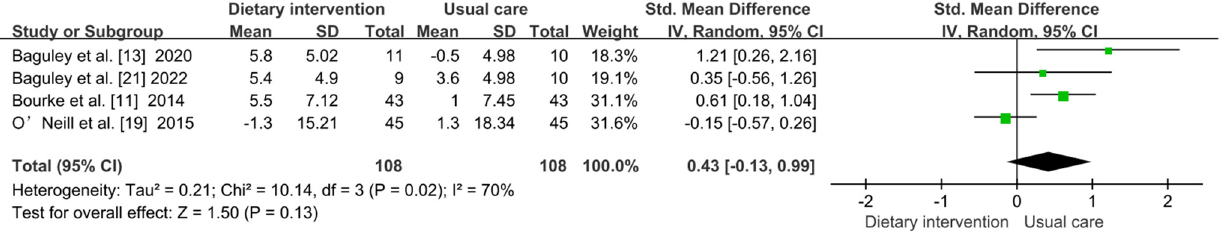
Figure 6. Fatigue: f orest plot of effect of healthy DP on fatigue. DP, dietary pattern; the diamond, effect size and 95%CIs; green color, weight.